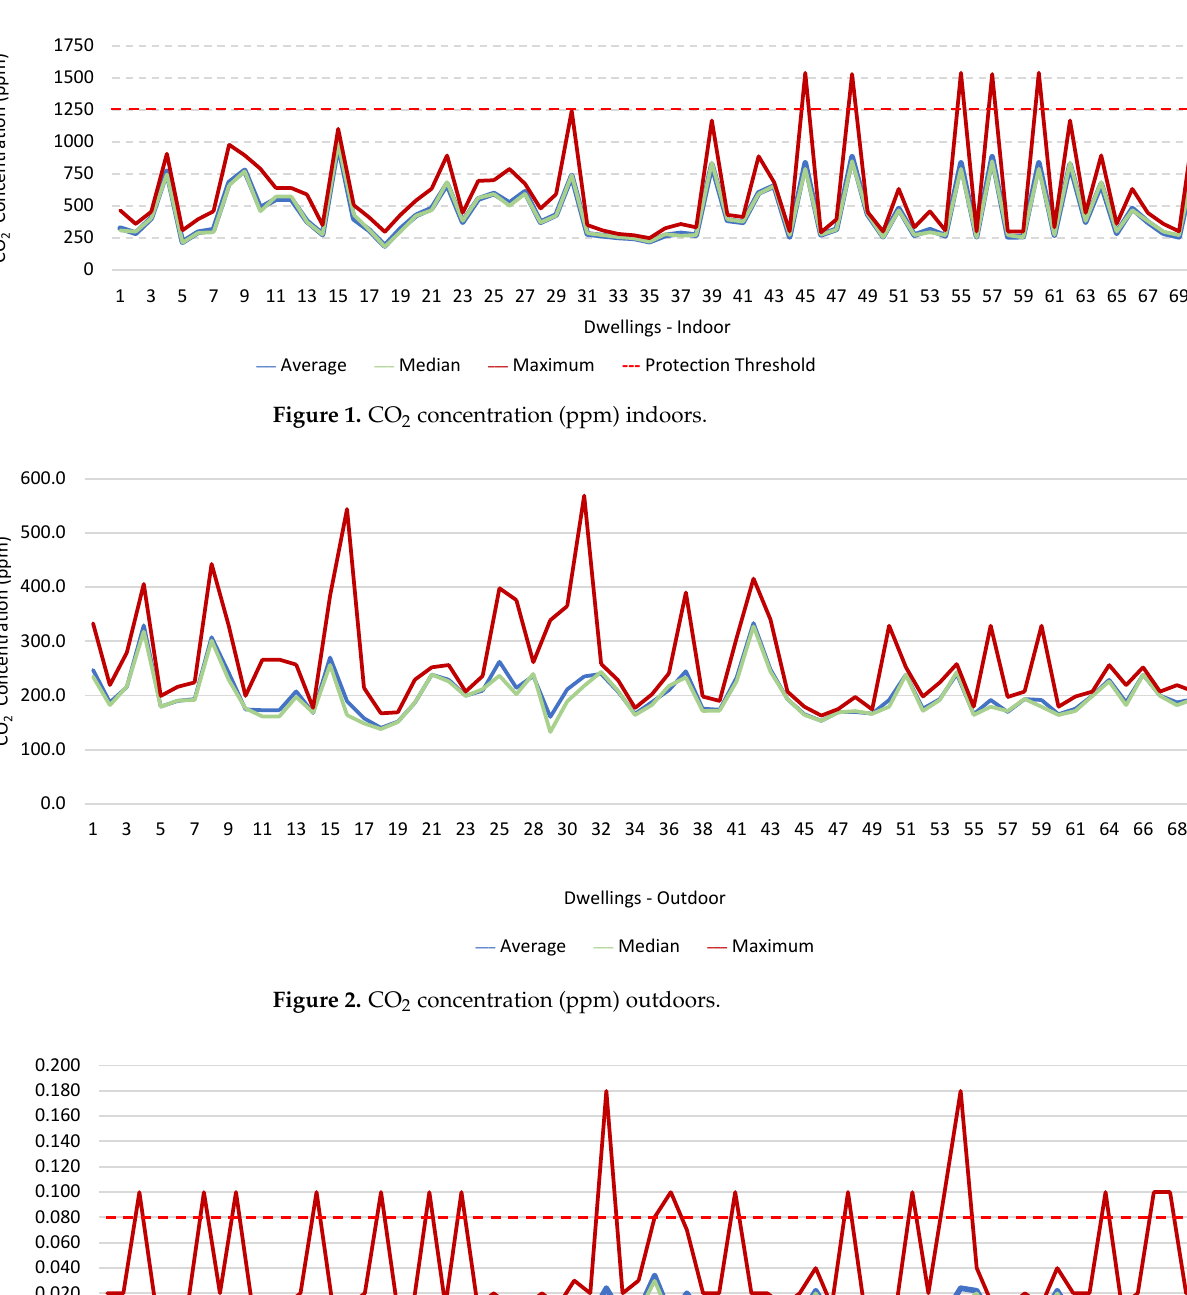
Figure 3. CH 2 O concentration (ppm) indoors.